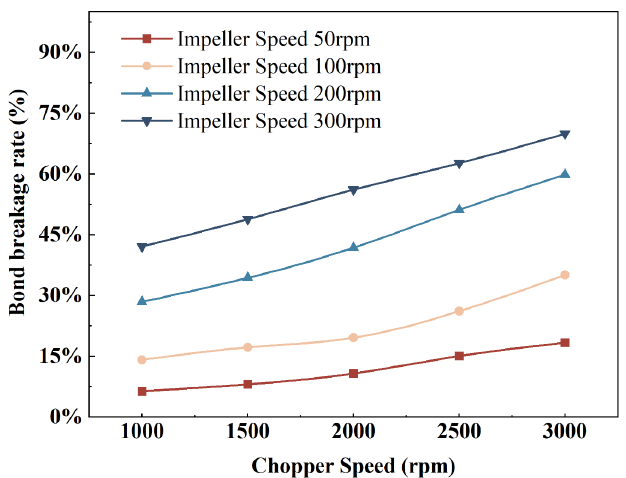
Figure 10. Overall Breakage rate.